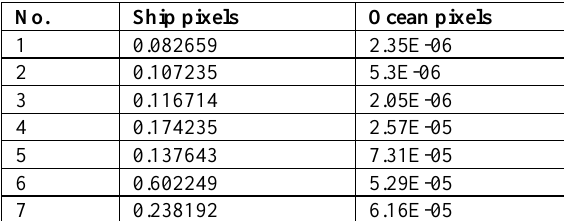
Fig. 9 ALOS1 Ship and ocean pixels [Variation of DOP] Analysis Table 6 ALOS1 Variation of DOP